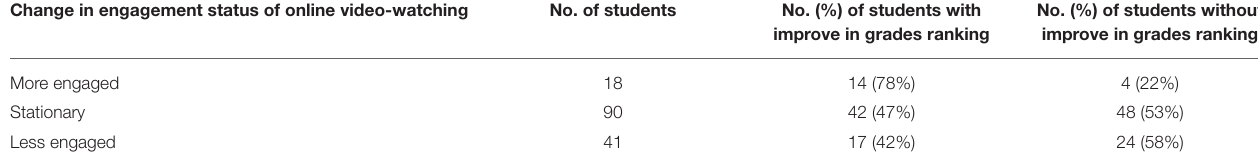
TABLE 4 | Improve in grades ranking between first and second halves of the Pharmacology course, stratified by the change in engagement status of online video-watching pattern ( p = 0.030 for inter-group difference by chi-square test). Change in engagement status of online video-watching